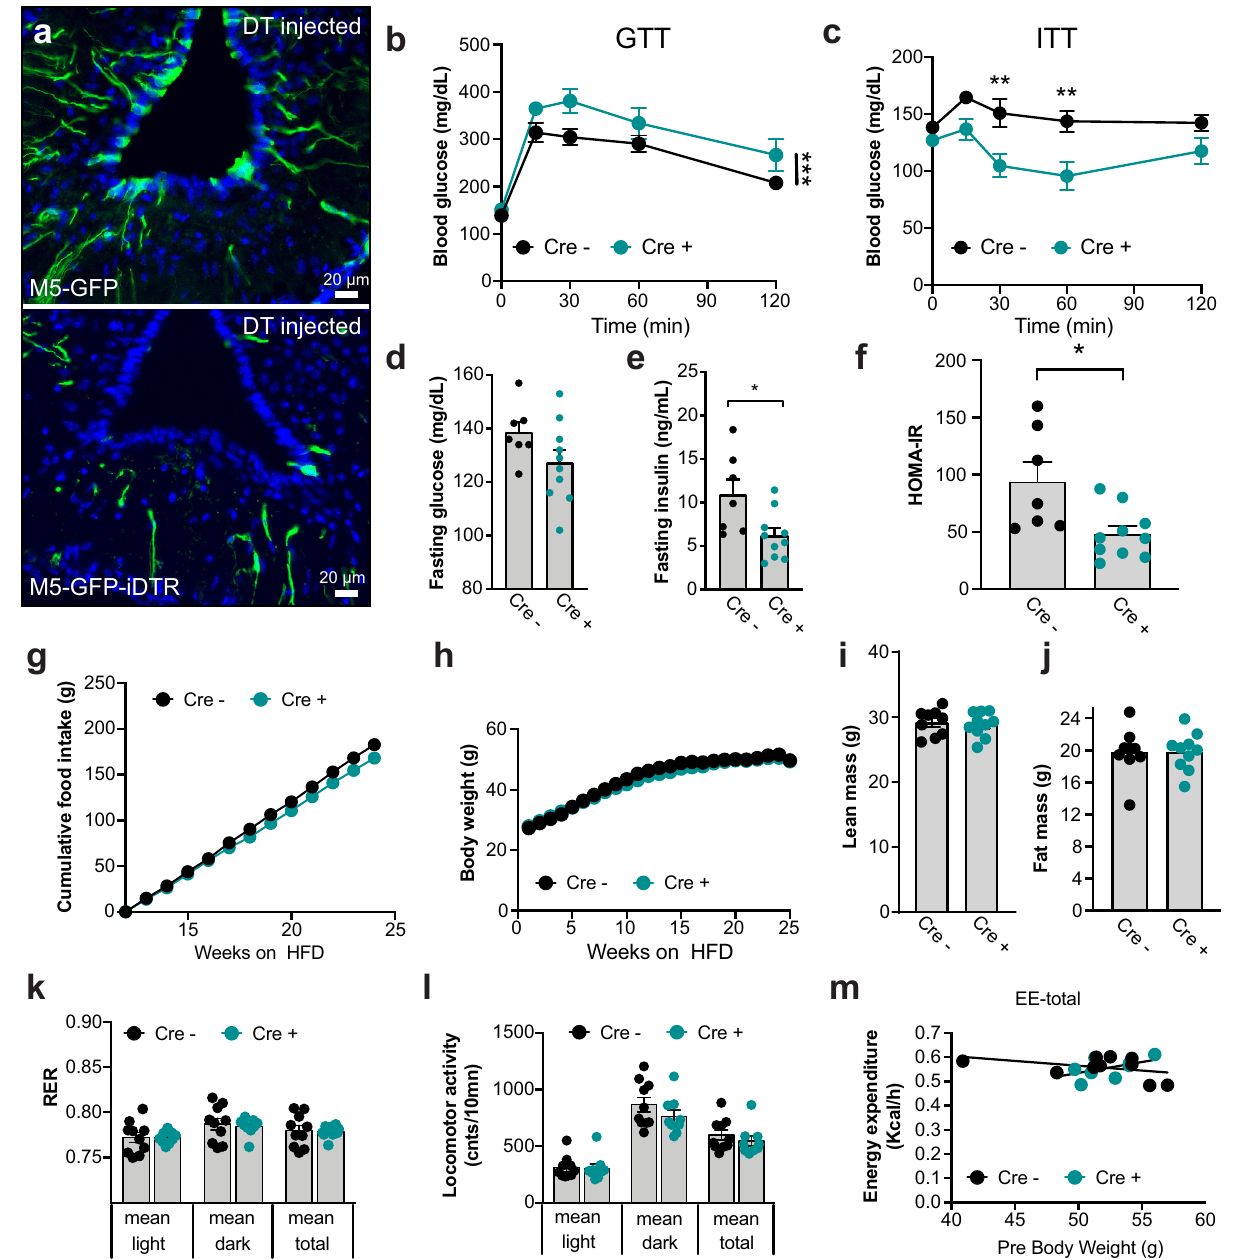
Fig. 6 | Acute M5 tanycyte ablation impairs glucose tolerance. a M5-GFP mice and M5-GFP-iDTR mice were bilaterally intra-hypothalamically injected with 0.5ng diphtheria toxin and perfused 7 days later. Note the ablation of the M5 tanycytes ( n =3). Scale bar: 20 µ m. b Glucose tolerance test (GTT) at age of 30 weeks ( n =10, p =0.0004). c – e Insulin tolerance test (ITT) ( p <0.01 for 30 and 60min), fasting glucose ( p =0.1096), and fasting insulin ( p =0.0181) in 48 weeks old WT mice and mice with DT-mediated M5 tanycyte depletion (Cre+) (Cre- n =7, Cre+ n=10). HOMA-IR f at the age of 48 weeks (Cre- n=7, Cre+ n =10, p =0.0123), food intake g (Cre- n =4, Cre+ n =7), body weight ( h ) (Cre- n=11, Cre+ n =10), body